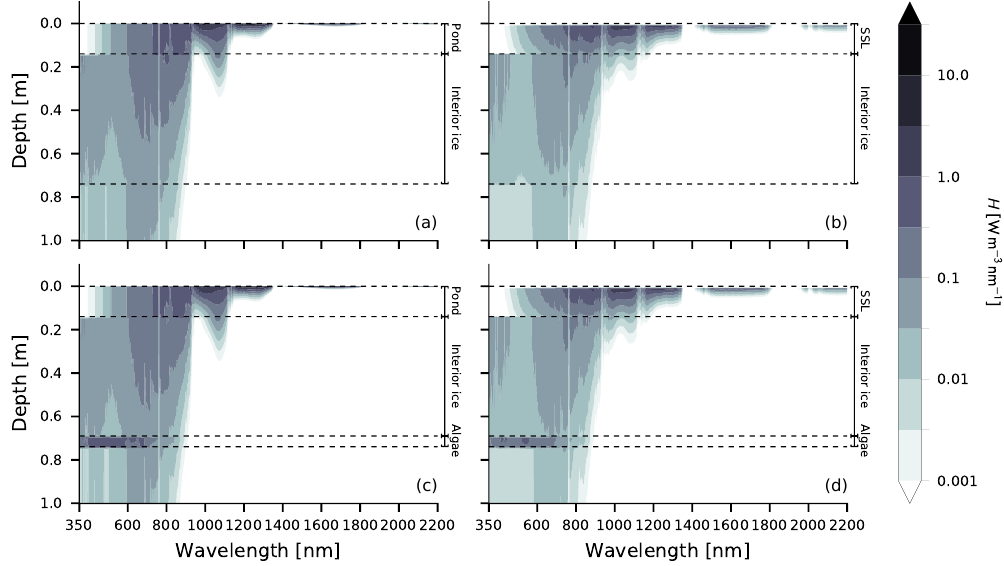
Figure 8. Absorbed energy calculated from simulated spectral irradiance using Gershun’s law, for ponded ice (a, c) and bare ice (b, d) . In (c, d) a chlorophyll concentration of 500mgm − 3 is added to the bottom 5cm of the